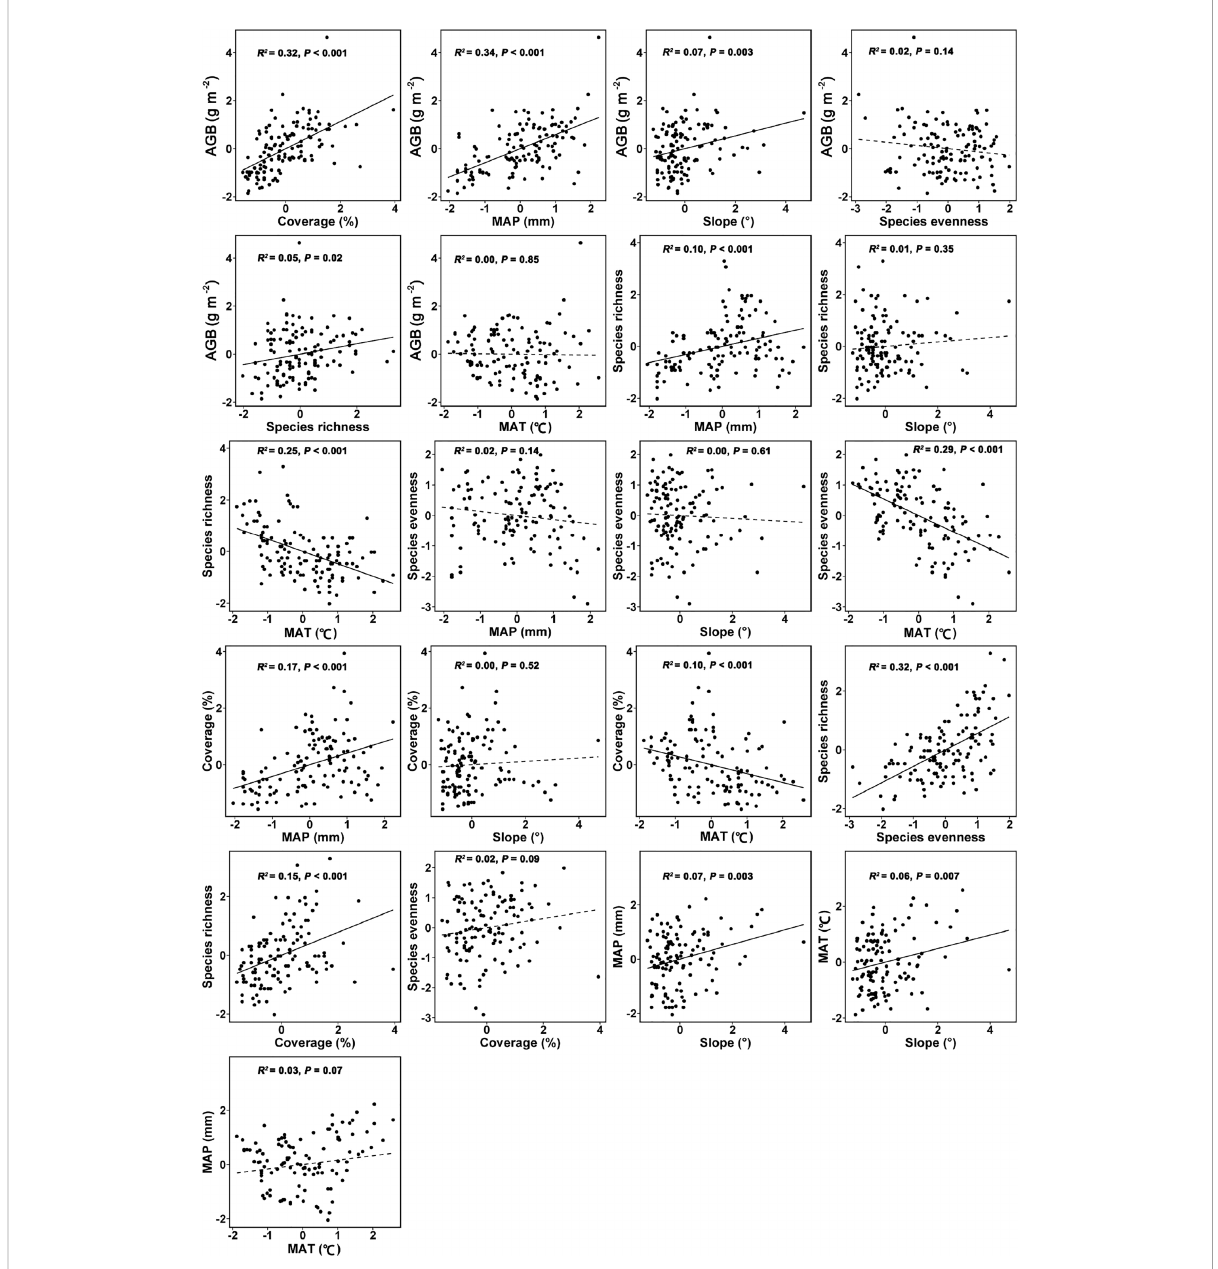
FIGURE 5 The bivariate relationships between tested variables used in the SEM for linking topographic slope, climatic factors (MAP and MAT), plant coverage, species richness, evenness and AGB of Leymus chinensis communities in northern China. Solid line represents a signi fi cant relationship whereas a dashed line represents a non-signi fi cant relationship. Abbreviations are explained in the caption of Figure